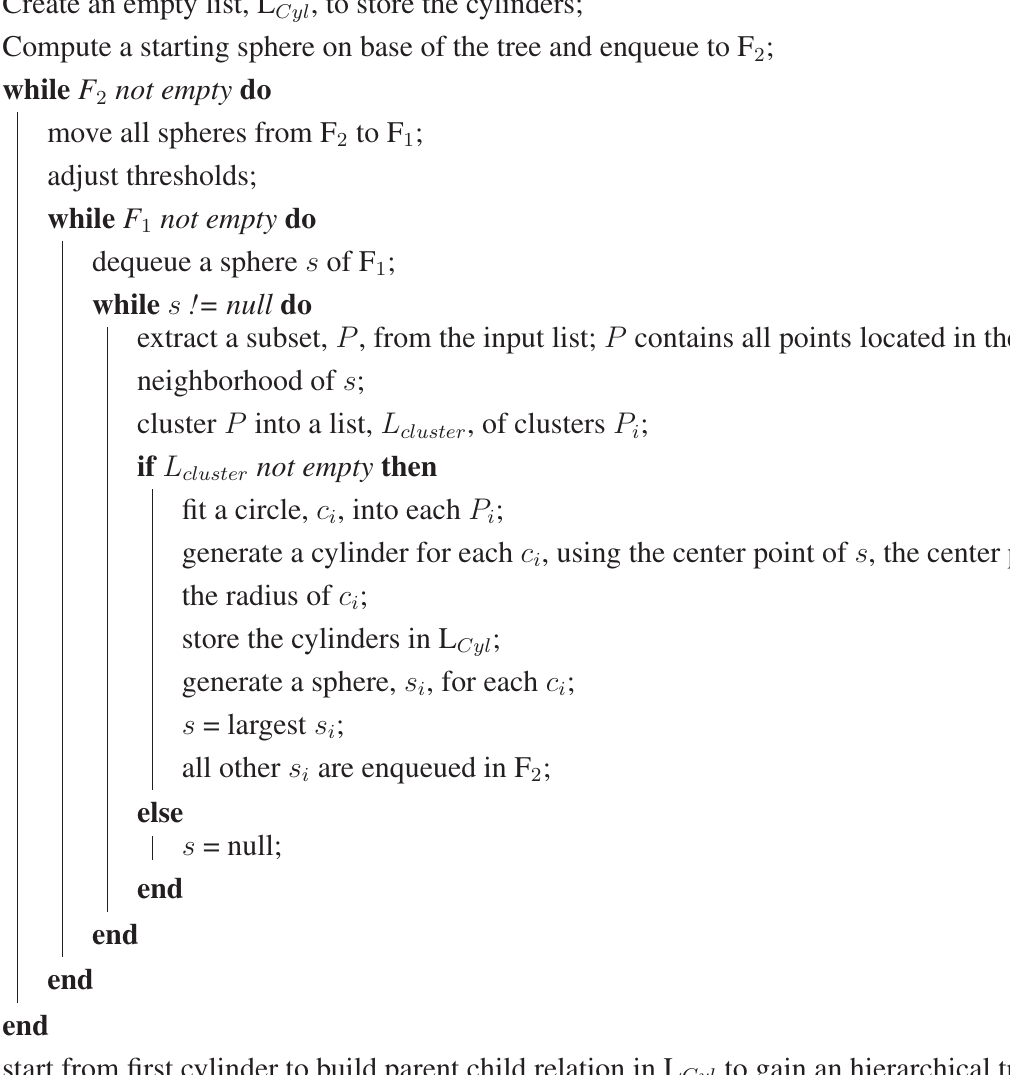
Algorithm 1: Cylinder model